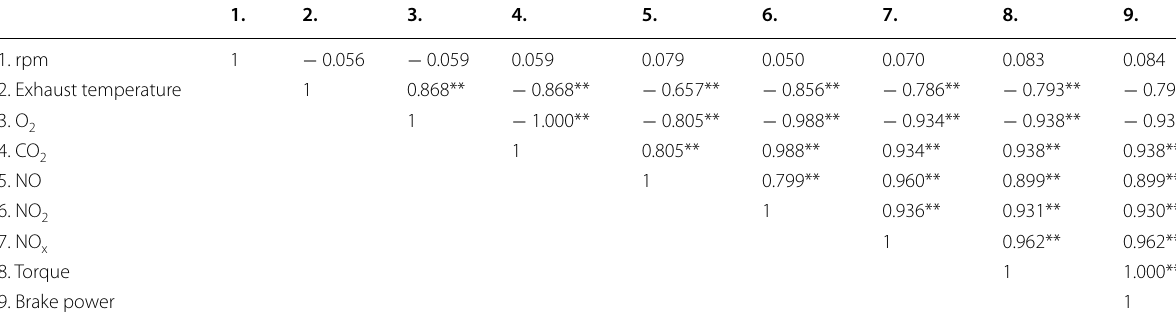
Table 5 Bivariate correlation coefficients for the whole experimental variables